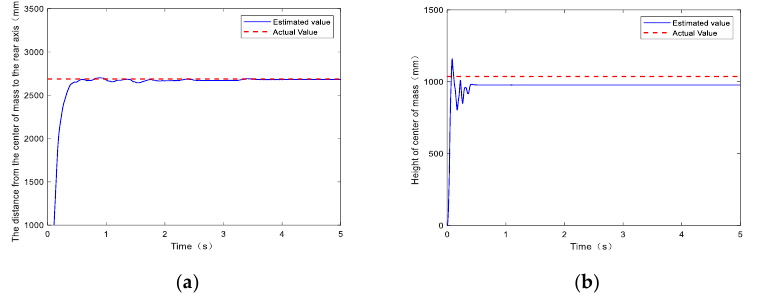
Figure 7. Estimation results of the center of gravity position of the vehicle without a load. ( a ) Distance from the center of gravity position to the rear axis; ( b ) height of the center of gravity.